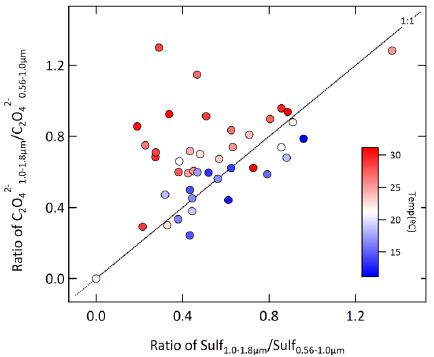
Figure 3. Comparison of mass concentration ratios of oxalate and sulfate between the two size bins 1.0–1.8 and 0.56–1.0µm. The data points are color-coded according to ambient temperature dur- ing their